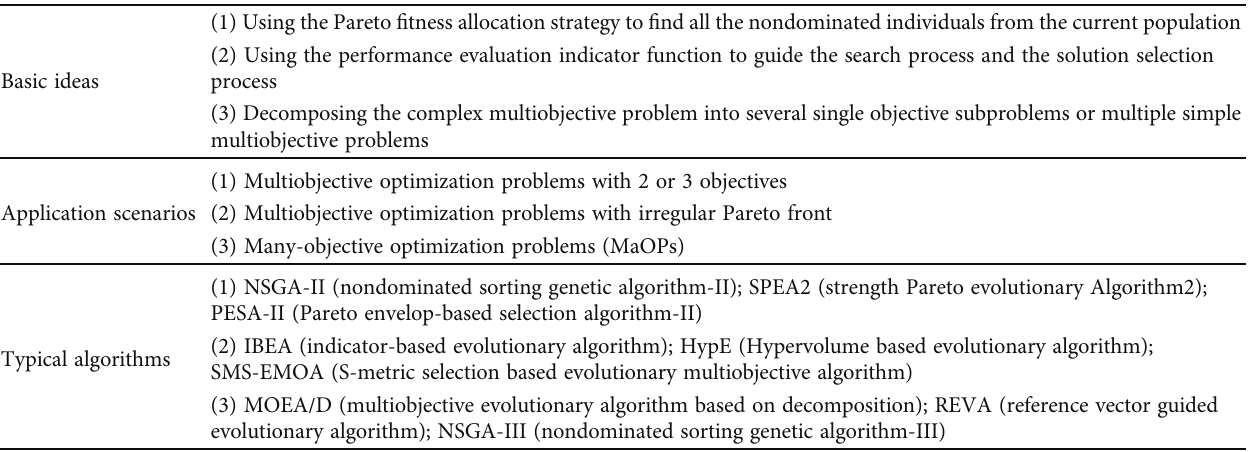
Table 1: An overview of MOEAs.